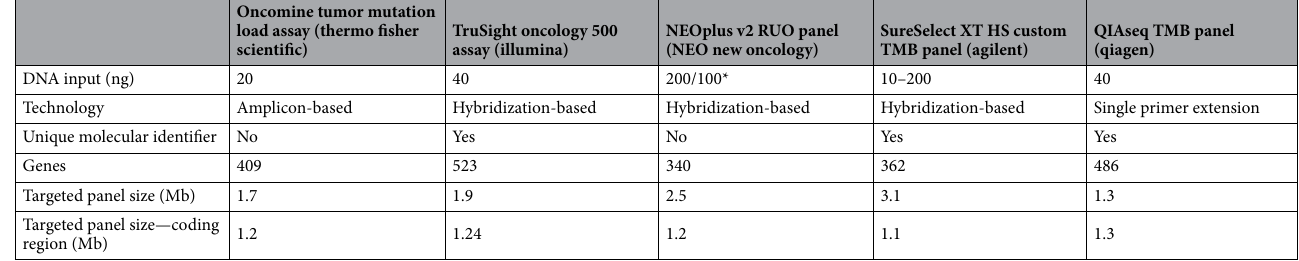
Table 1. Comparison of the five TMB panels. Comparison of features for the different gene panels; only coding regions were used in the analysis. *for explanation, see “Methods”